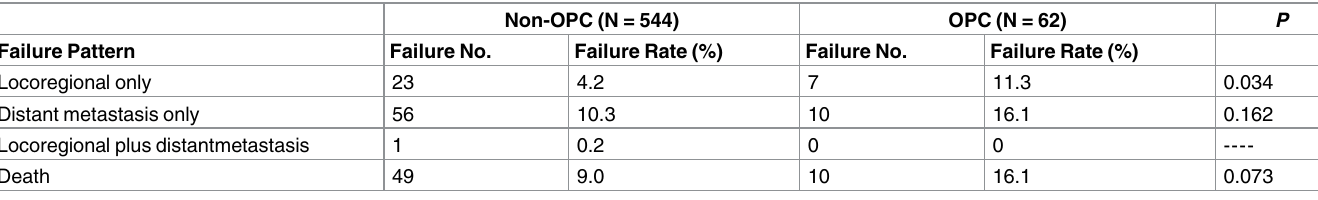
Table 3. Patterns of disease failure in patients treated with non-OPC versus